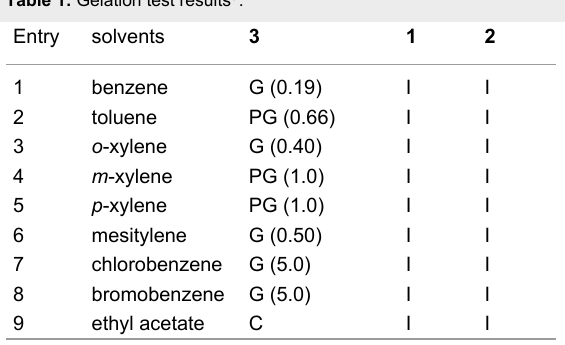
Table 1: Gelation test results a .